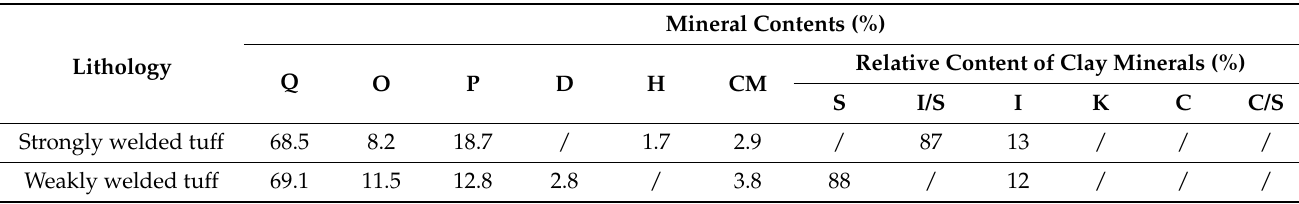
Table 1. The mineralogical composition of the welded tuff.